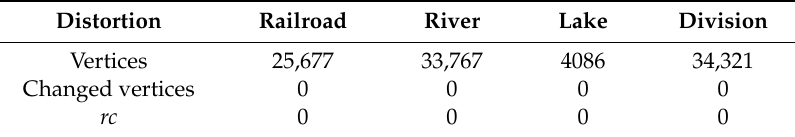
Table 3. The change rates of coordinate